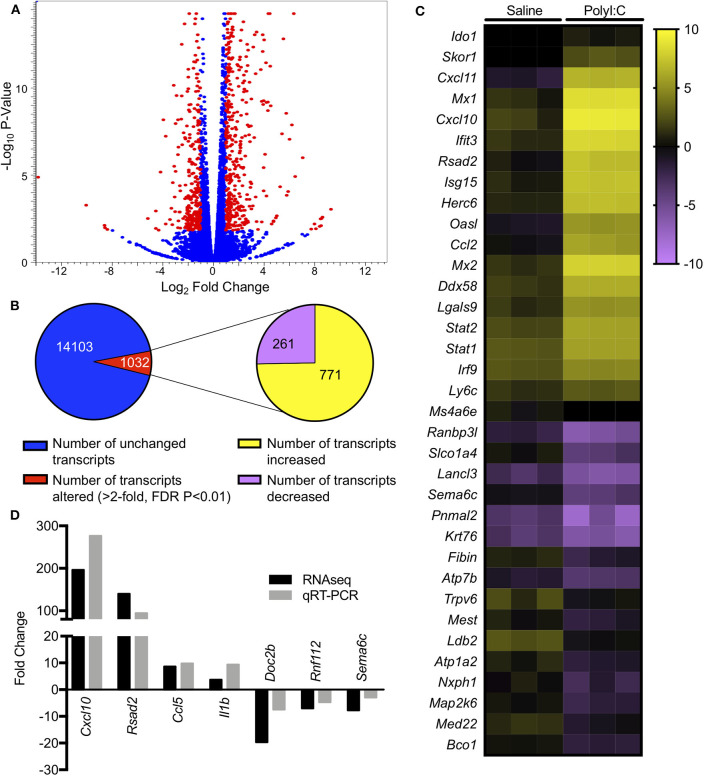
Gene expression changes in the conceptus following maternal exposure to PolyI:C. (A) Volcano plot depicting number of unique transcripts expressed in the conceptus following PolyI:C exposure relative to conceptuses exposed to saline. The x-axis represents magnitude of fold-change (log2), and the y-axis shows P-value (log10). Transcripts altered 2-fold or more (false discovery rate P < 0.01) following PolyI:C are shown in red. (B) Pie chart showing number of transcripts upregulated and downregulated in conceptuses exposed to PolyI:C compared to those exposed to saline. (C) Heat map showing RPKM values (log2) of select transcripts in conceptuses following maternal exposure to saline or PolyI:C. (D) Quantitative RT-PCR validation of select transcripts in relation to values obtained using RNA-Seq. Data are normalized to values obtained from saline-exposed conceptuses. All data are based on lysates from three conceptuses pooled from each of three dams (nine conceptuses total) per treatment.